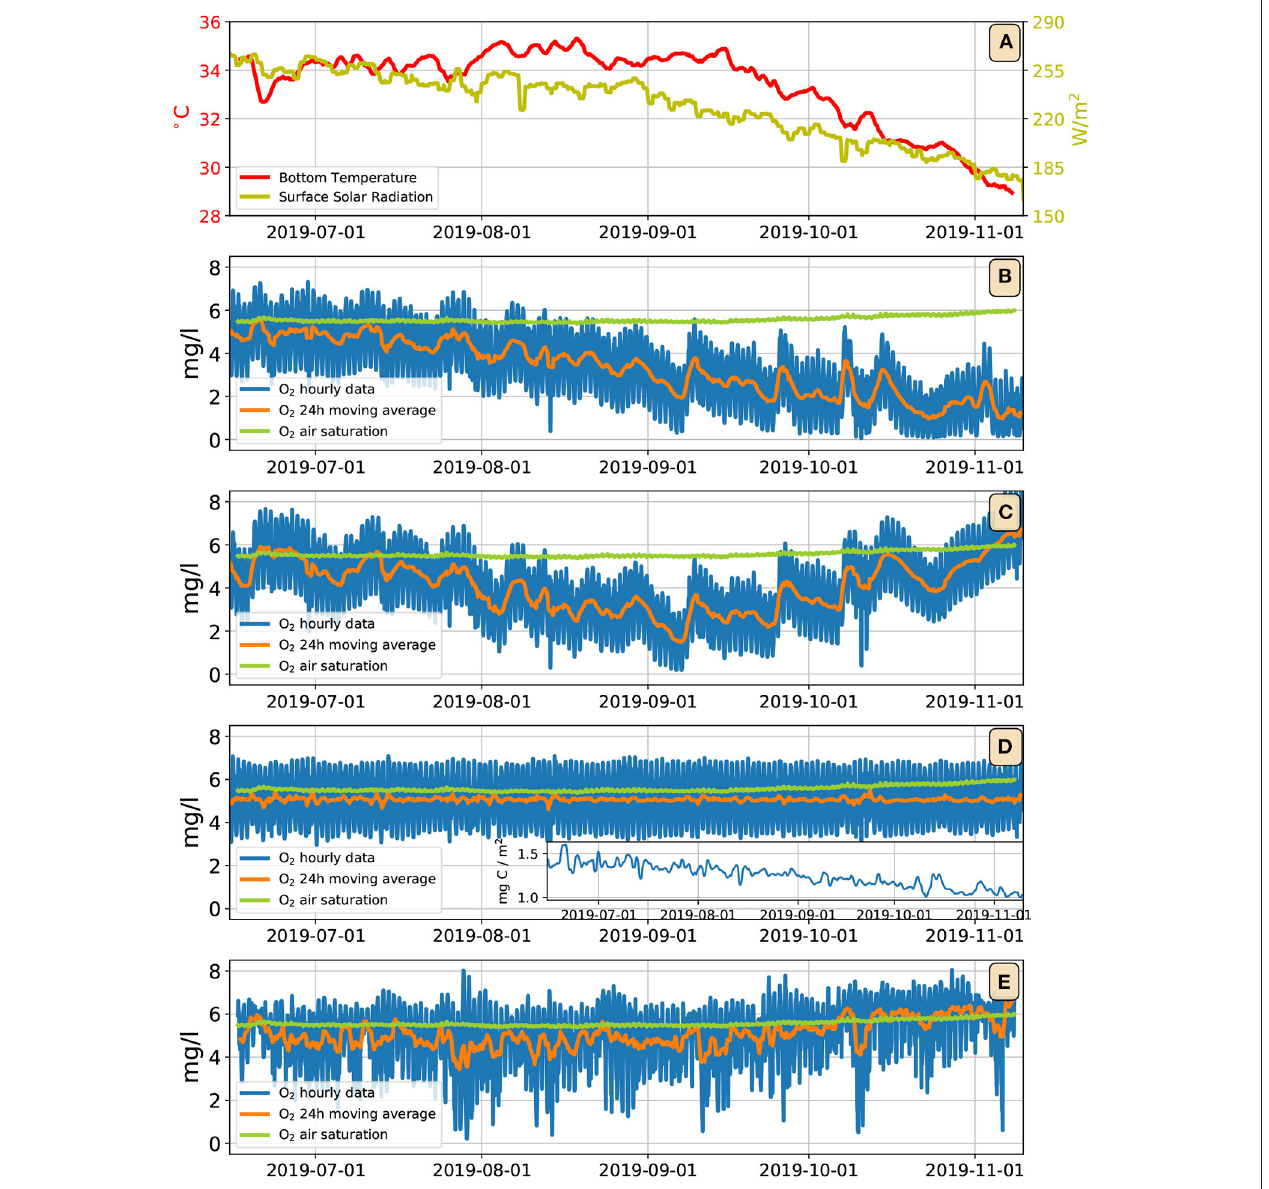
FIGURE 8 | (A) Dark yellow line: daily running mean solar irradiance at the top of the water column; red line: daily running mean bottom water temperature. (B) Output of the model of Figure 5C extended up to November; blue line: bottom oxygen concentration; orange line: daily running mean of the bottom oxygen concentration; green line: oxygen air saturation concentration. (C) Same model as (B) , but with an Arrhenius temperature dependence on the bottom respiration fluxes. (D) Same model as (B) , but with bottom fluxes determined by the microbial model of Equations (7)–(9); the inset shows the daily running mean of benthonic microbial concentration. (E)